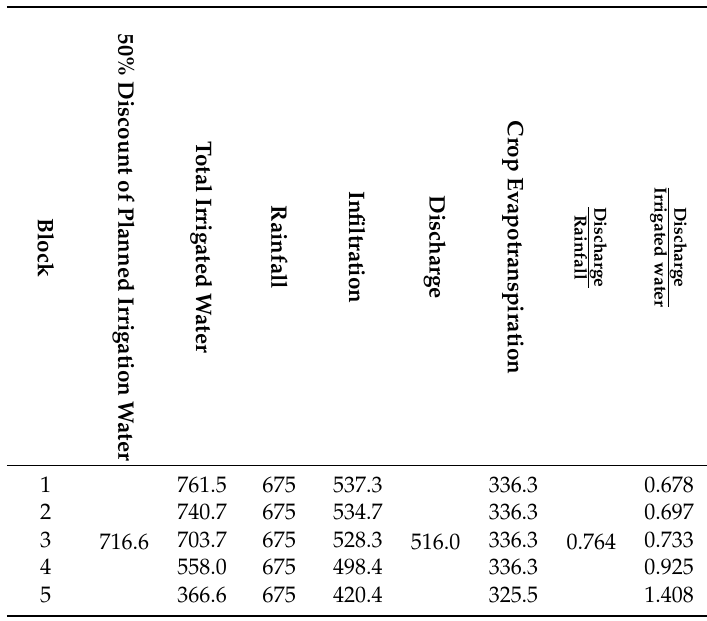
Table 6. Simulation of 50% reduction of planned irrigation water depth (mm) during the first crop